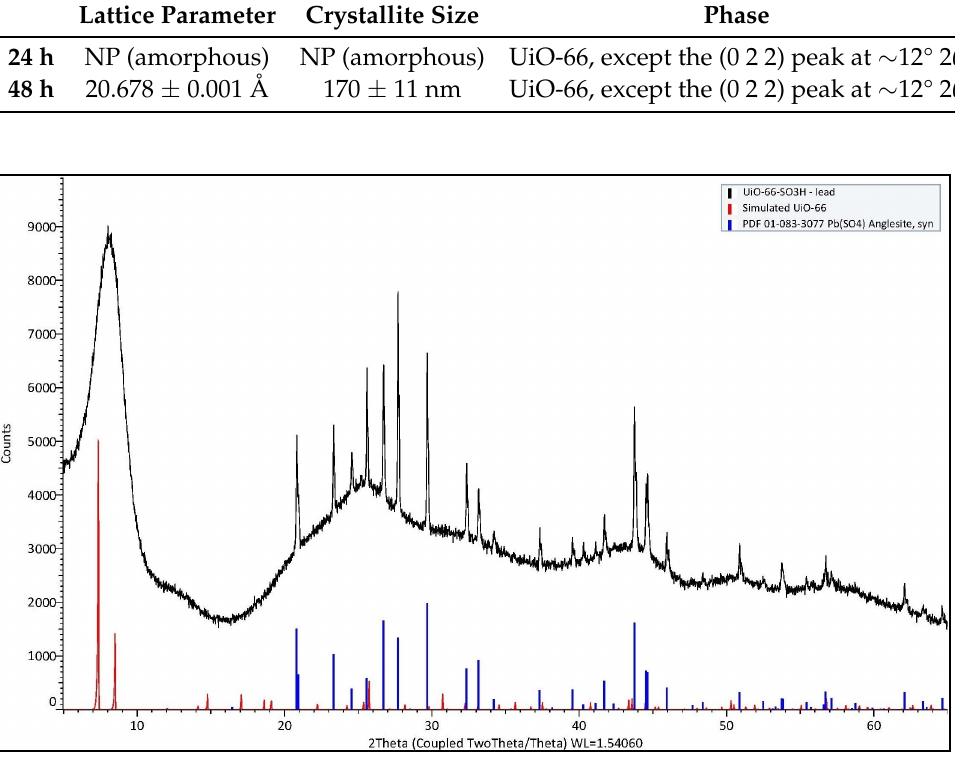
Figure A1. Diffractogram pattern of SO 3 Pb-UiO-66(Zr) at 2 θ region (5°–65°), superimposed over the simulated diffractograms of UiO-66 and PbSO 4